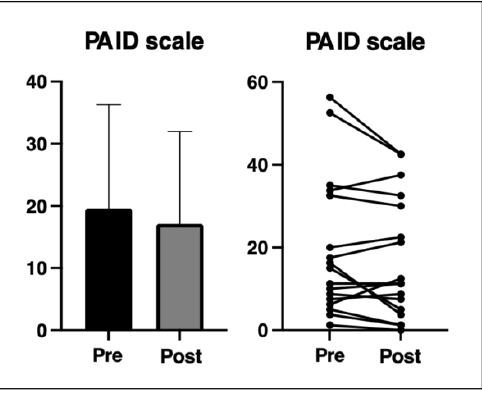
Figure 4. Problem Areas in Diabetes (PAID) scale results pre- and post-intervention (n = 17). Means ± standard deviation (SD).